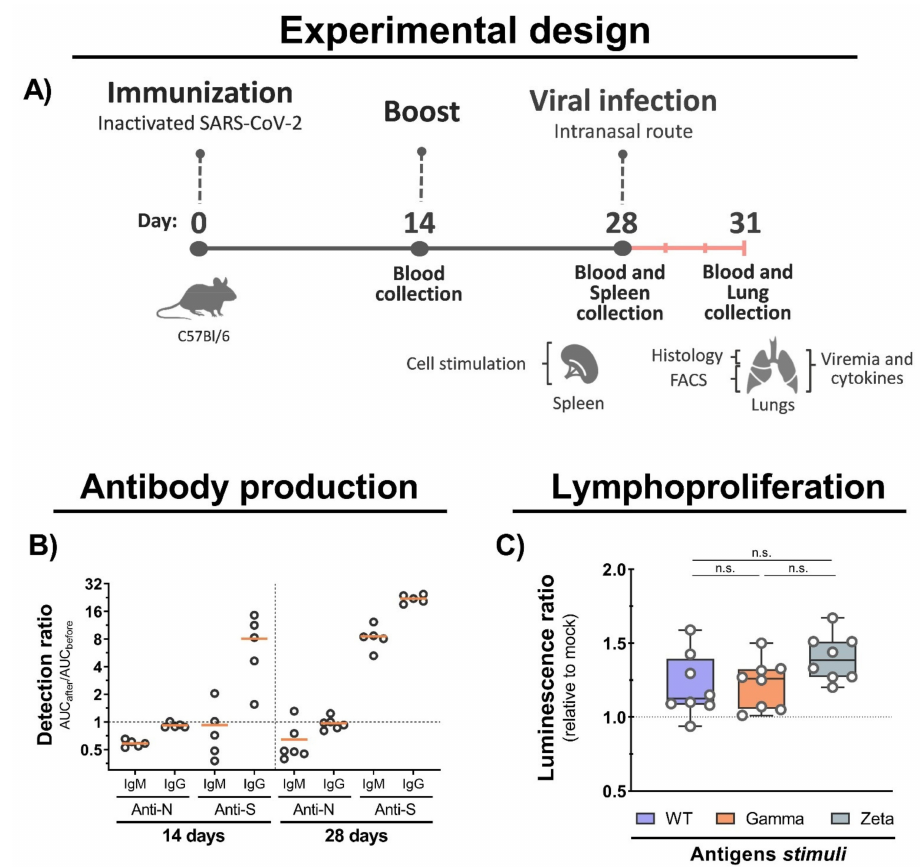
Figure 3. Mouse immunization, antibody production, and cellular immune response. ( A ) C57BL/6 mice were intramuscular immunized with inactivated WT SARS-CoV-2 at days 0 and 14, and in- tranasally infected with 7 × 10 4 PFU (WT/Gamma/Zeta) at day 28. Blood serum samples collected at 14 and 28 days after immunization, and 3 days after infection, and used for antibody analysis. Spleen organs collected on day 28 and used for lymphoproliferation assay. Three days after in- fection, mice were euthanized and the lungs collected for analysis. ( B ) IgM and IgG antibodies production anti-N and anti-S after 14, and 28 days of initial immunization were detected by indirect ELISA. AUC from immunized mice was normalized with AUC from the same mice before infection. ( C ) Lymphoproliferation assay was performed with splenocytes from immunized and nonimmunized mice stimulated for 5 days with 10 µ g of inactivated viral antigens of WT SARS-CoV-2, Gamma or Zeta viral lineage. Statistical analysis was conducted by one-way ANOVA followed by Tukey’s post hoc test. n.s. = not statistically significant; AUC = area under curve; IgM = immunoglobulin M; IgG = immunoglobulin